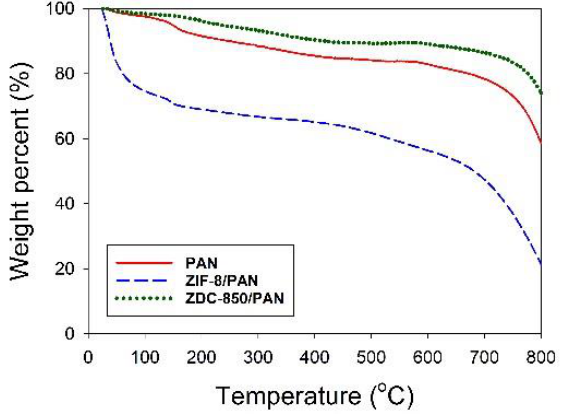
Figure 3. The TGA patterns of PAN, ZIF-8/PAN, and ZDC-850/PAN.